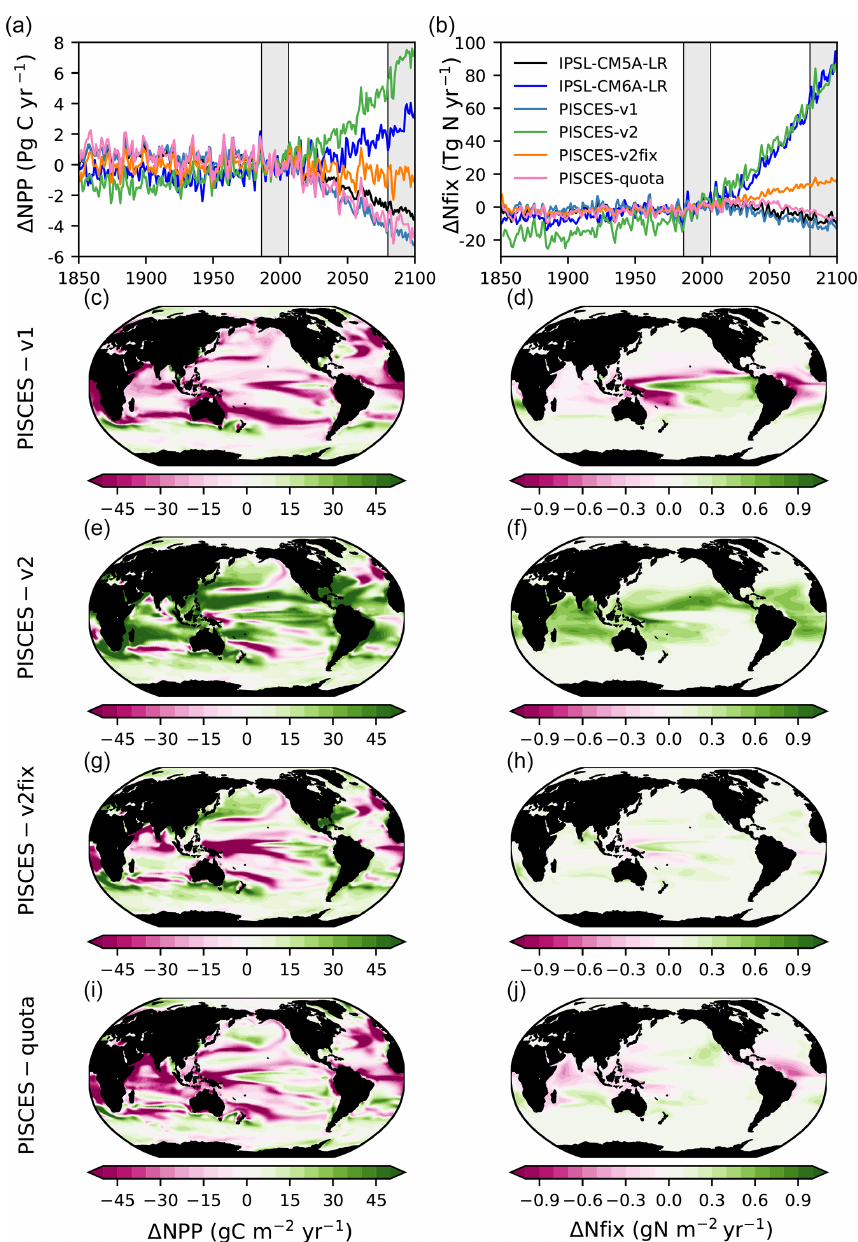
Figure 4. Changes in NPP and N fixation across all model versions. Time series of (a) global NPP anomalies (PgCyr − 1 ) and (b) global N-fixation anomalies (TgNyr − 1 ), relative to 1986–2005 and under historical, RCP8.5 (all model versions except IPSL-CM6A-LR) and SSP5-8.5 (only IPSL-CM6A-LR). Changes in (c, e, g, i) vertically integrated NPP (gCm − 2 yr − 1 ) and in (d, f, h, j) vertically integrated N fixation (gNm − 2 yr − 1 ) for all offline model versions in 2080–2099 relative to 1986–2005, under